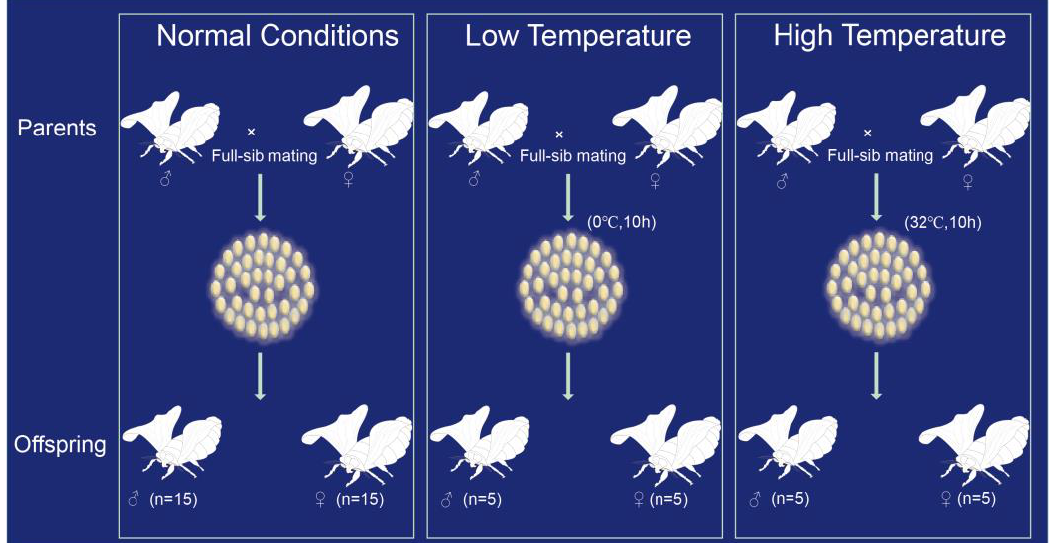
Figure 1. Three full-sib families were reared at different temperatures. For the normal condition family, each individual was reared at 25 °C under a 12:12 h (L:D) photoperiod. For the two temper- ature-stress-inducing families, eggs after one hour of oviposition were treated with either high tem- perature (32 °C, 10 h) or low temperature (0 °C, 10 h). Then, all treatment individuals were reared under the same conditions as the normal family.